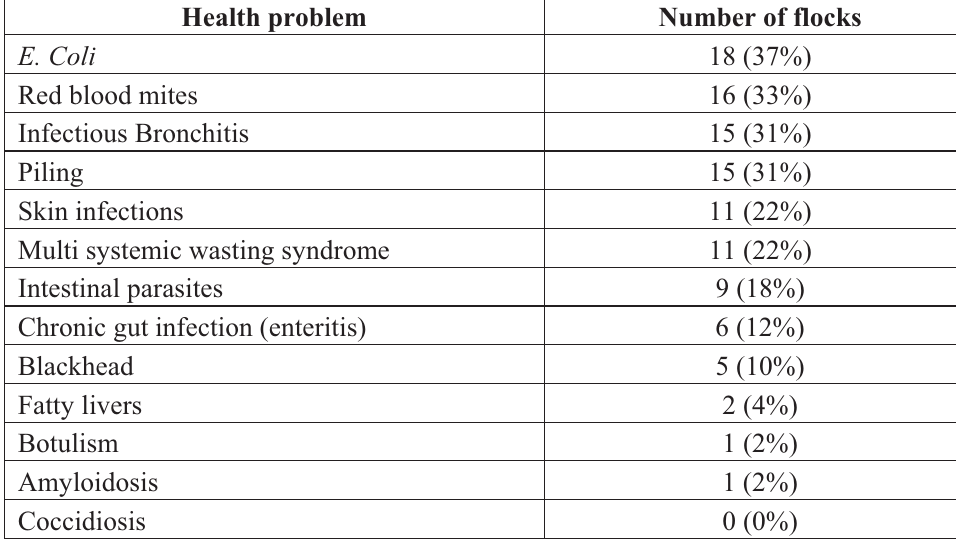
Table 7. Presence of health